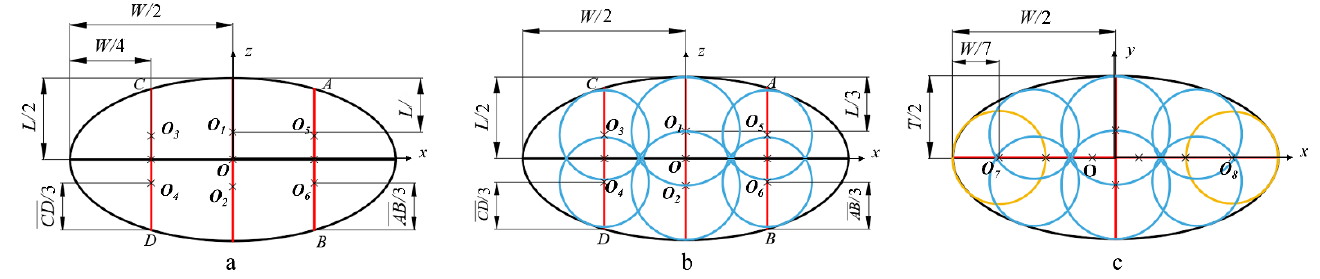
Figure 12. ( a – c ) Filing methods for the multi-sphere model of Jinong 2. The filing method for the 7-sphere model of Jinong 3 was as follows: the width ( W ), length ( L ), and thickness ( T ) of the seed were aligned on the major axis (axis x ), the middle axis (axis z ), and the minor axis (axis y ) of the ellipsoid, respectively. On the xoz plane, first, the width W of the ellipsoid was divided into trisections, and two line segments AB and CD , which were parallel to axis z and intersecting with the ellipsoid outline, were made through the diversion points. Then, the parallel line segments AB and CD were divided into trisections, as shown in Figure 13a. Moreover, the equal diversion points (point O 1 , point O 2 , point O 3 , and point O 4 ) were the centers of the new filing spheres. Thus, four spheres that were tangential to the outline of the ellipsoid were filled, defined as sphere O 1 , sphere O 2 , sphere O 3 , and sphere O 4 , as shown in Figure 13b. In addition, on the xoy plane, the width W of the ellipsoid was divided into five parts, and the equal diversion points (point O 5 and point O 6 ) were only considered as the centers of the new filing spheres. Thus, another two spheres that were tangential to the outline of the ellipsoid were filled, defined as sphere O 5 and sphere O 6 , as shown in Figure 13c. Fi- nally, the last sphere O 7 was filled at the position of the hilum. As a result, seven total spheres were filled. Based on the filing principle, 7-sphere, 9-sphere, and 11-sphere mod- els of Jinong 3 were successively modeled, as shown in Figure 14g–i.